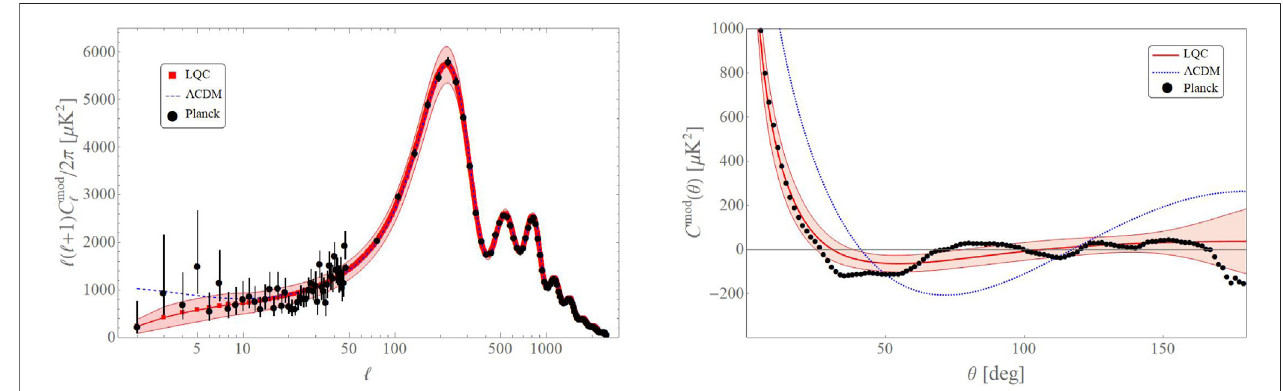
FIGURE 6 | Form of the modulated power spectrum for a typical value of the suppression. The fi gure shows that the monopolar modulation can account for the suppressionofpowerat multipoleslowerthan ℓ ≈ 30 (A) .Inthe (B) ,wealsoseethatthesuppression translates toaverylowrealspace powerspectrum C ( θ )for θ ≥ 60 ° . The shaded region shows cosmic variance, and the black dots data from